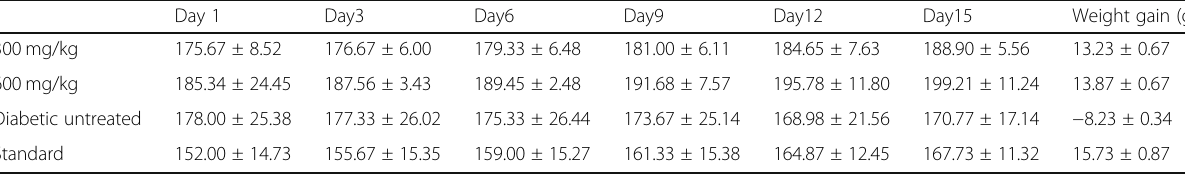
Table 5 Effect of Chromolaena odorata on body weight of Diabetic treated albino